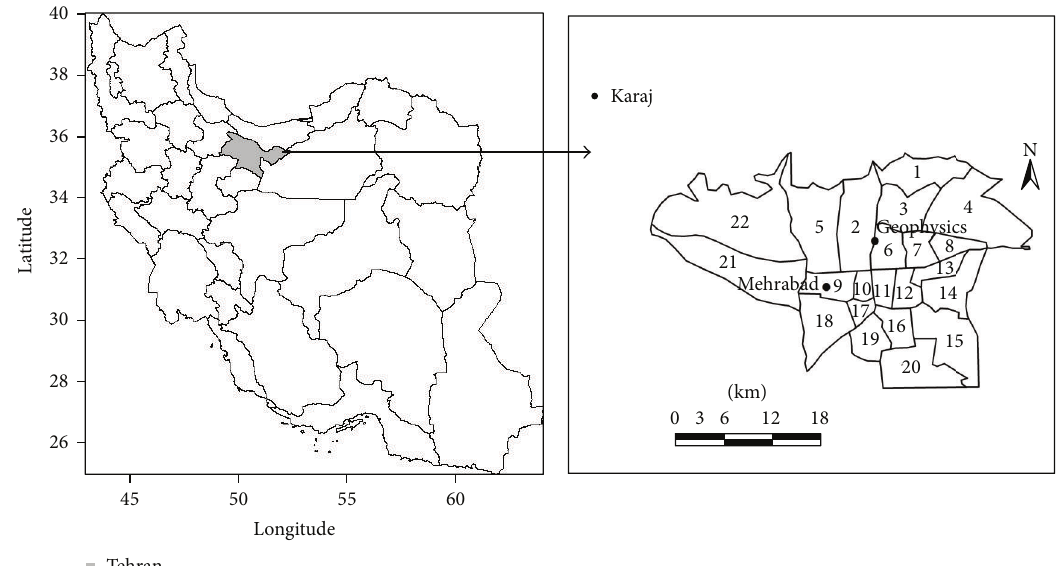
Figure 3: The location of Tehran and three meteorological stations Geophysics (GEO), Mehrabad (MHR), and Karaj.